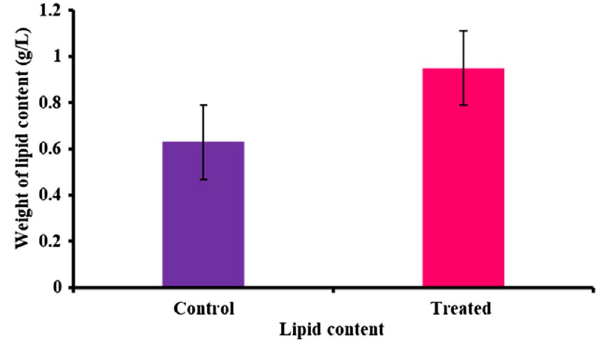
Fig. 3 Estimation of lipid content from microalgae Chlorella sp.